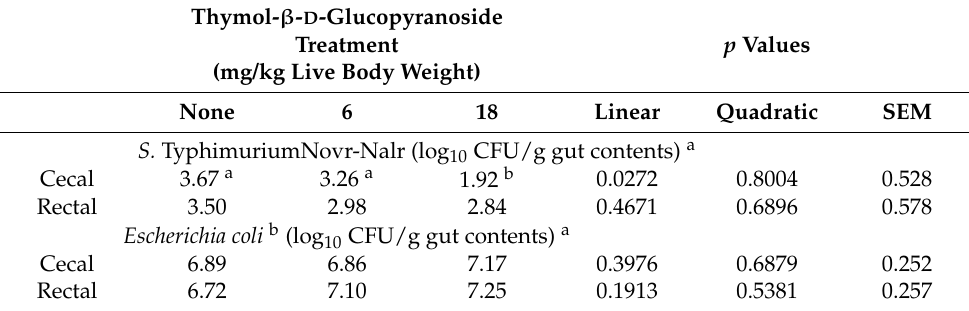
Table 1. Effect of oral thymol- β - D -glucopyranoside treatment on gut novobiocin- and nalidixic acid-resistant Salmonella Typhimurium ( S. TyphimuriumNovr-Nalr) and generic E. coli in weaned swine. Thymol- β - D -Glucopyranoside Treatment (mg/kg Live Body Weight) None